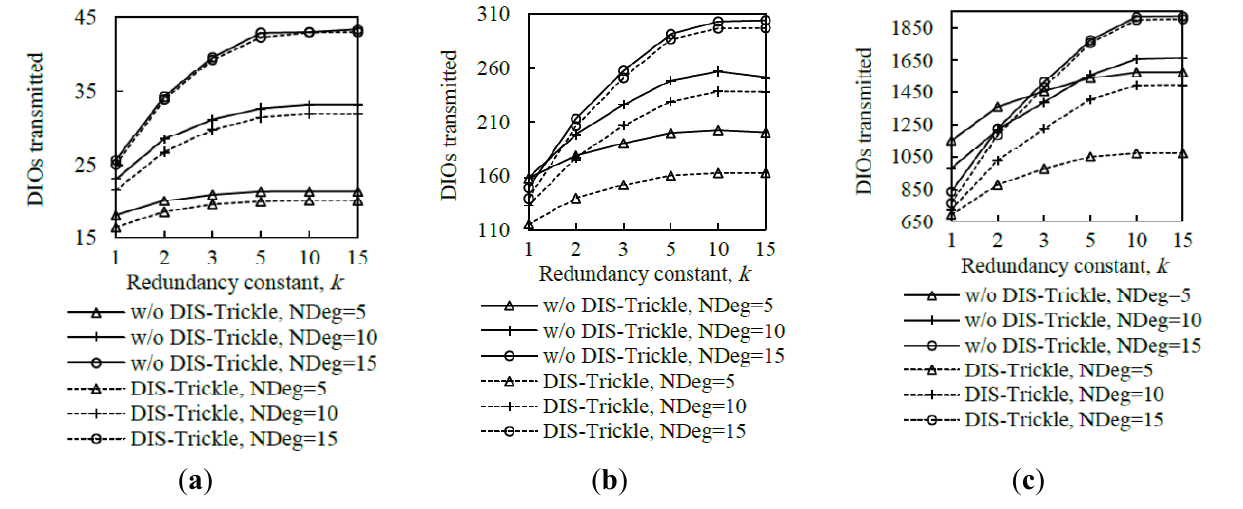
Figure 17. Influence of using DIS-Trickle on the number of DIO messages transmitted in the small, medium and large network scenarios, for different average node degrees, NDeg, as a function of the redundancy constant, k , when the I network size, ( b ) medium network size, and ( c ) large network size.